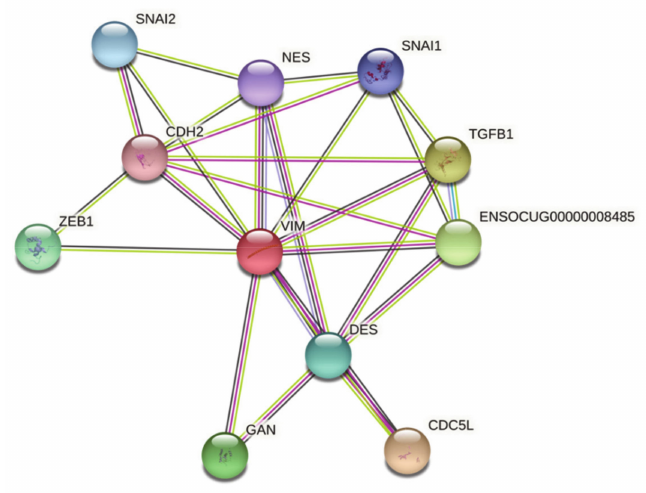
Figure 3. Search Tool for the Retrieval of Interacting Genes (STRING) analysis of VIM . Interacting nodes are displayed in colored circles. All abbreviations are listed in the dedicated subsection at the end of the